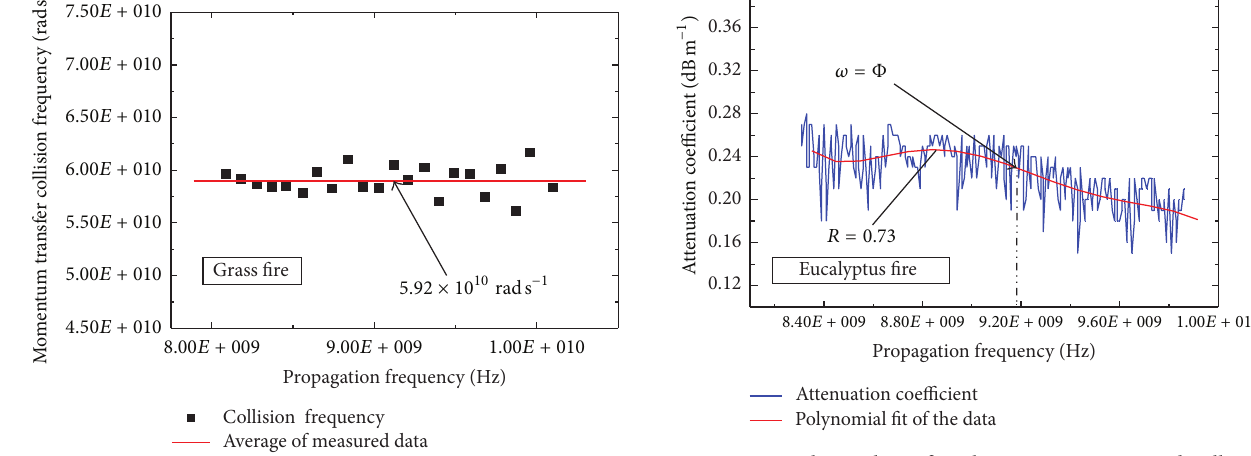
Figure 3: Measured collision frequency for the grass fire.